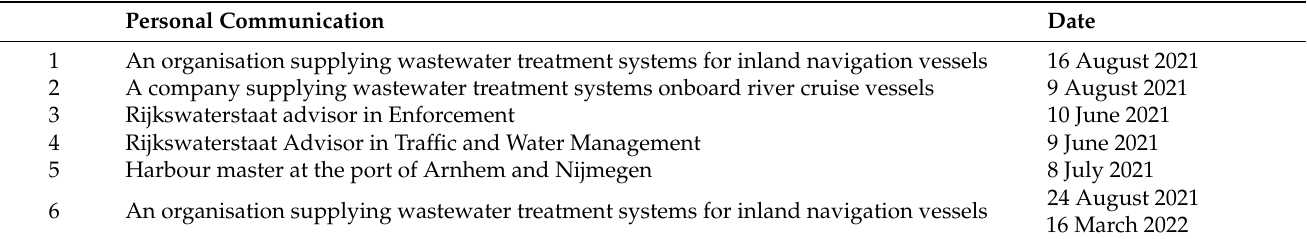
Table A3. Personal communication with